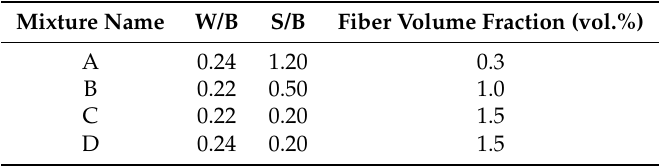
Table 1. Mixture proportions for composites under